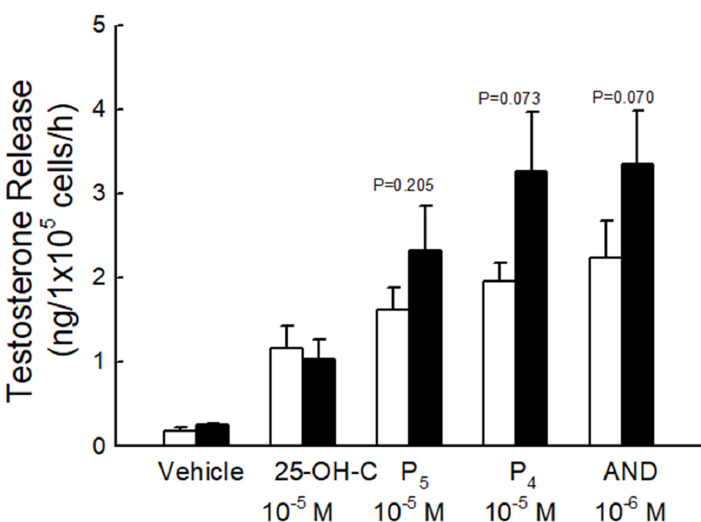
Figure 6. Testosterone release in response to different precursors. Basal and evoked testosterone release in response to different precursors in rat Leydig cells purified from the fructose-diet fed group (black column) and the control group (white column). Testosterone was determined after treating Leydig cells with different precursors including 25-hydroxycholesterol (25-OH-C), pregnenolone (P 5 ), progesterone (P 4 ), and androstenedione (AND) for 1 h. Each value presents mean ± SEM. Similar results were repeated twice.